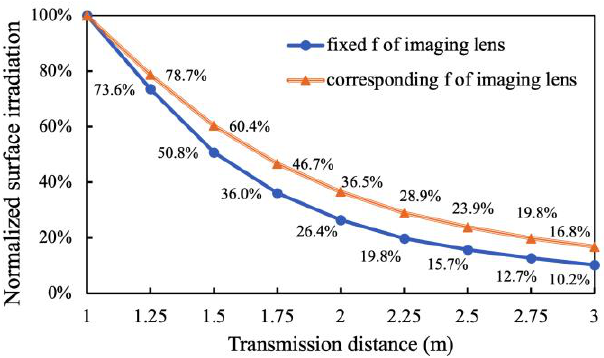
Figure 11. Longer distance transmission performance with a 50 × 50 mm 2 size solar cell.